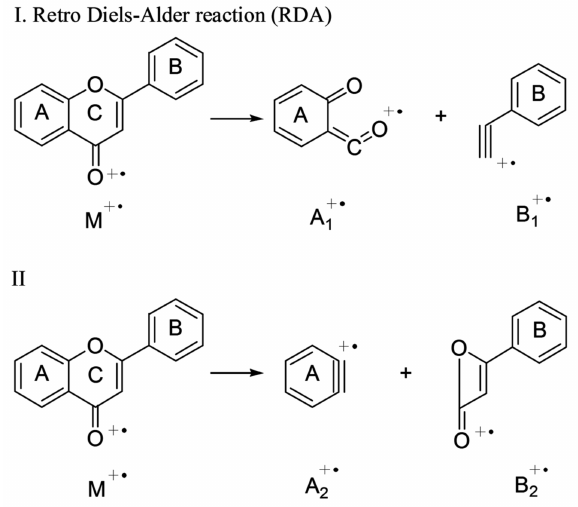
Figure 3. The fragmentation pathway of